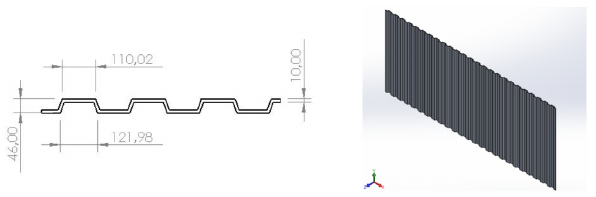
Figure 6: Geometrical model of the corrugated wall